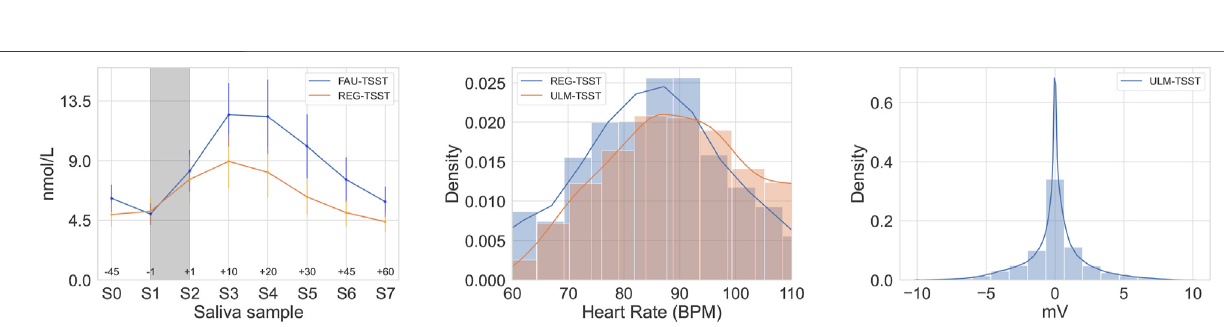
FIGURE 1 | An overview of the typical TSST paradigm, as applied in FAU-TSST and REG-TSST , where ULM-TSST excludes the arithmetic task.